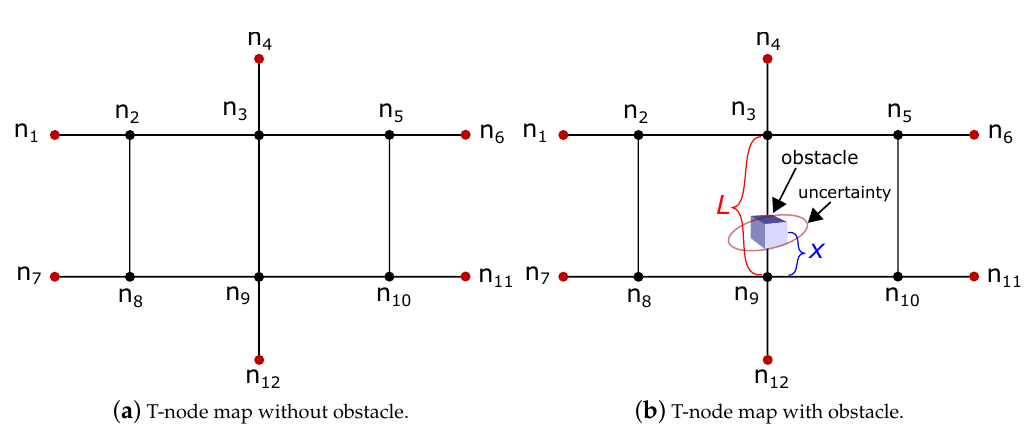
Figure 4. T-node representation of the environment shown in Figure 1. ( a ) T-node map without obstacle. ( b ) T-node map with obstacle between nodes n 9 n 3 .